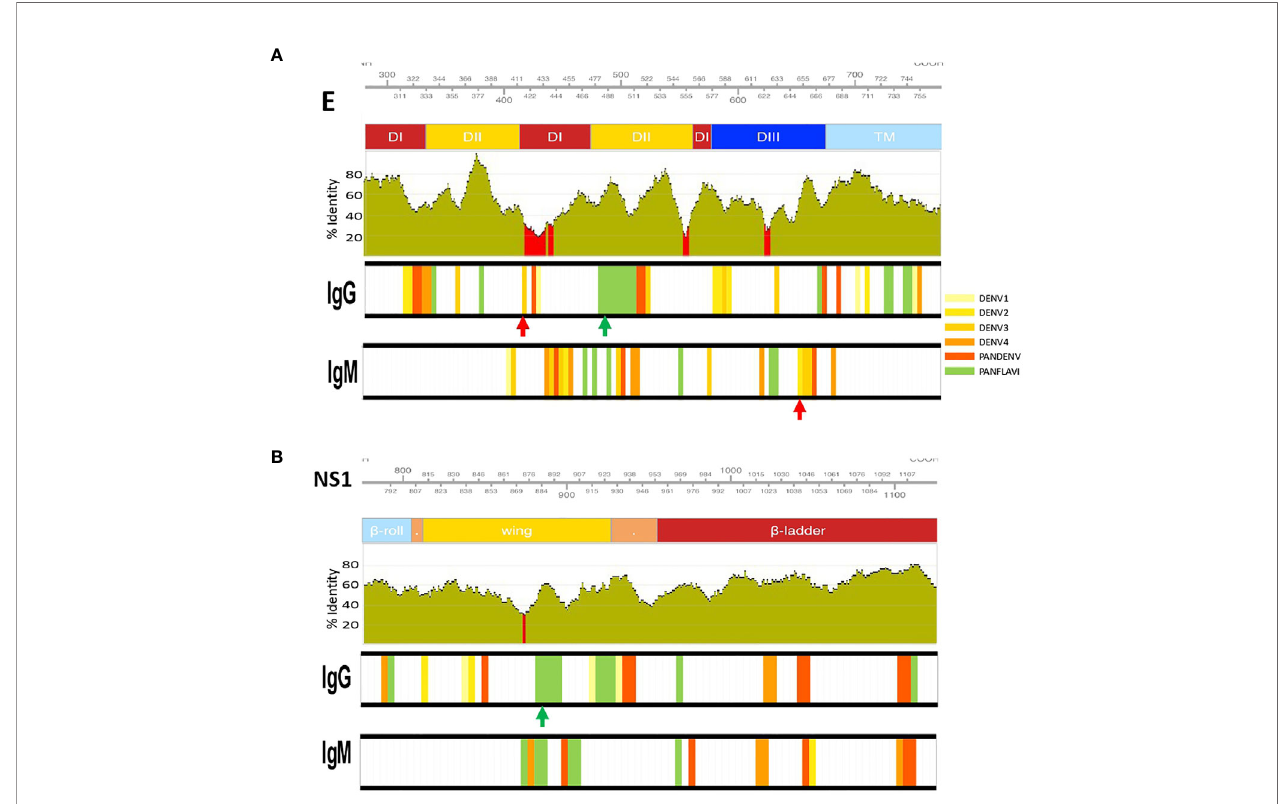
FIGURE 7 | Identi fi cation of DENV speci fi c and fl avivirus broadly immunoreactive epitopes. IgM and IgG targeted epitopes at the E (A) and NS1 (B) proteins from DENV, ZIKV and YFV viruses, recognized by DENV patients were fi ltered out and mapped to the proteomic coordinates of DENV (Uniprot ref: P33478). Colored bars from light-yellow to orange represent immunodominant regions belonging to one DENV serotype. Red bars represent immunodominant regions belonging to more than one serotype (here called PanDENV). Green bars represent immunodominant regions belonging to DENV and ZIKV or/and YFV here called PanFlavi. E and NS1 sequences from DENV1-4, ZIKV and YFV were aligned and the conservation rate (percentage identity) between the amino acid positions is represented as green bar plots using a sliding window size of 15 amino acid positions. Red regions correspond to percentage identities below 30%. Red and green arrows are DENV-speci fi c and PanFlavi peptides, respectively, and for which the Ab responses are further detailed in Supplementary Figure S13